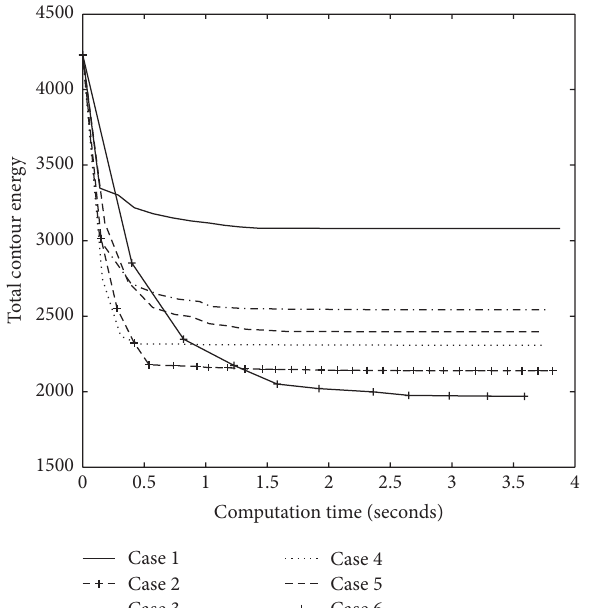
Figure 10: Contour energy versus computation time plot for “proposed multiswarm PSO” method with six different cases of inertia in case of “Peppers” image.